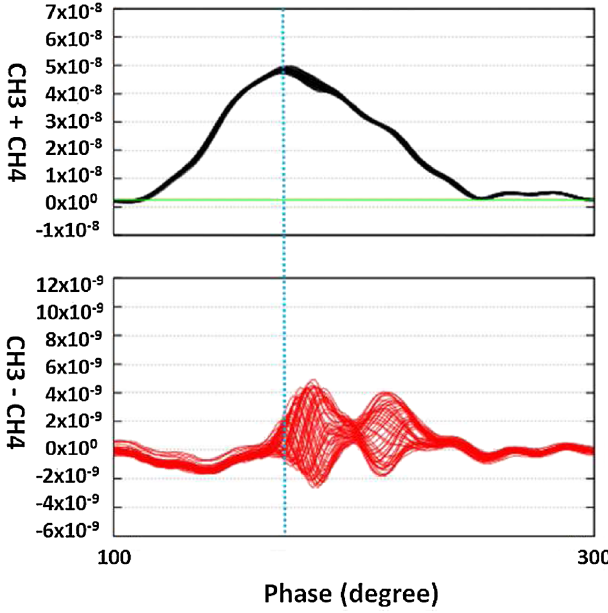
peak.FIG. 5. (Color) The vertical centroid oscillations in the tail part, case 0, measured at 13.88 ms for 50 consecutive turns. CH3 and CH4 are the top and bottom BPM